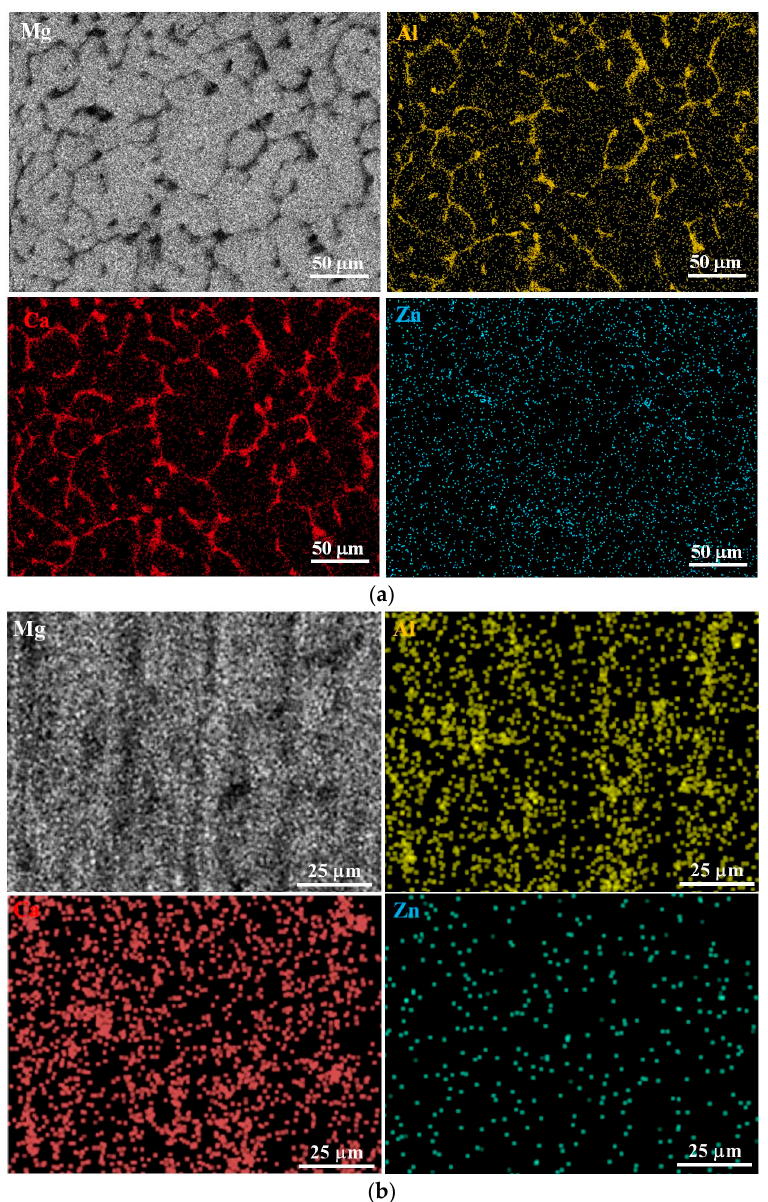
Figure 3. Scanning electron microscope—energy dispersive spectroscopy (SEM-EDS) map showing elemental distribution of AZ31-2Ca alloy for ( a ) as-cast and ( b ) DMD processed conditions.